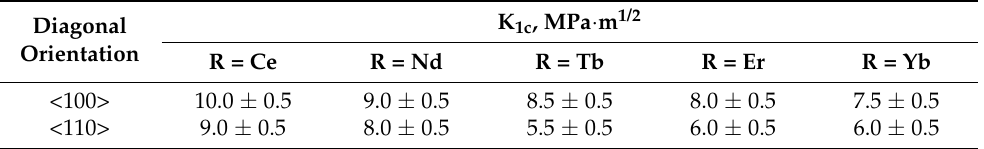
Table 4. Fracture toughness for the 2.5Y0.5RSZ and 2.5Y0.7RSZ crystals (R = Ce, Nd, Tb, Er, Yb and Sc).